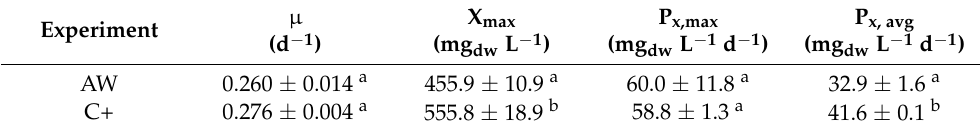
Table 2. Kinetic growth parameters calculated for the AW and C+